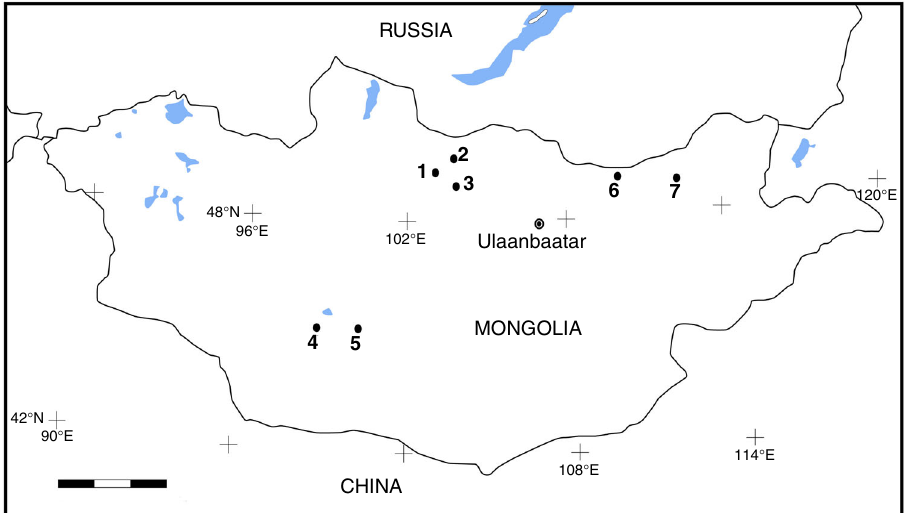
Fig. 1 Map showing Upper Paleolithic sites in Mongolia. 1 — Tolbor sites, 2 — Dörölj, 3 — Orkhon sites, 4 — Chickhen sites, 5 — Tsagaan Agui, 6 — Rashaan Khad and 7 — Salkhit. Chronometric data for these sites is listed in Supplementary Table 1. Blocks on scale bars represent 100